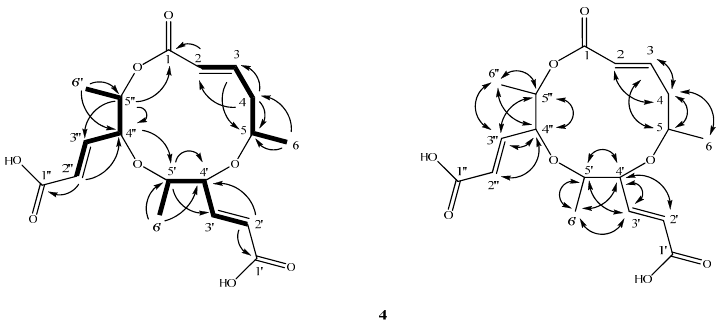
Figure 3. Key HMBC (H → C), COSY (bold line), and NOESY (H ↔ H) correlations for compound 4 .